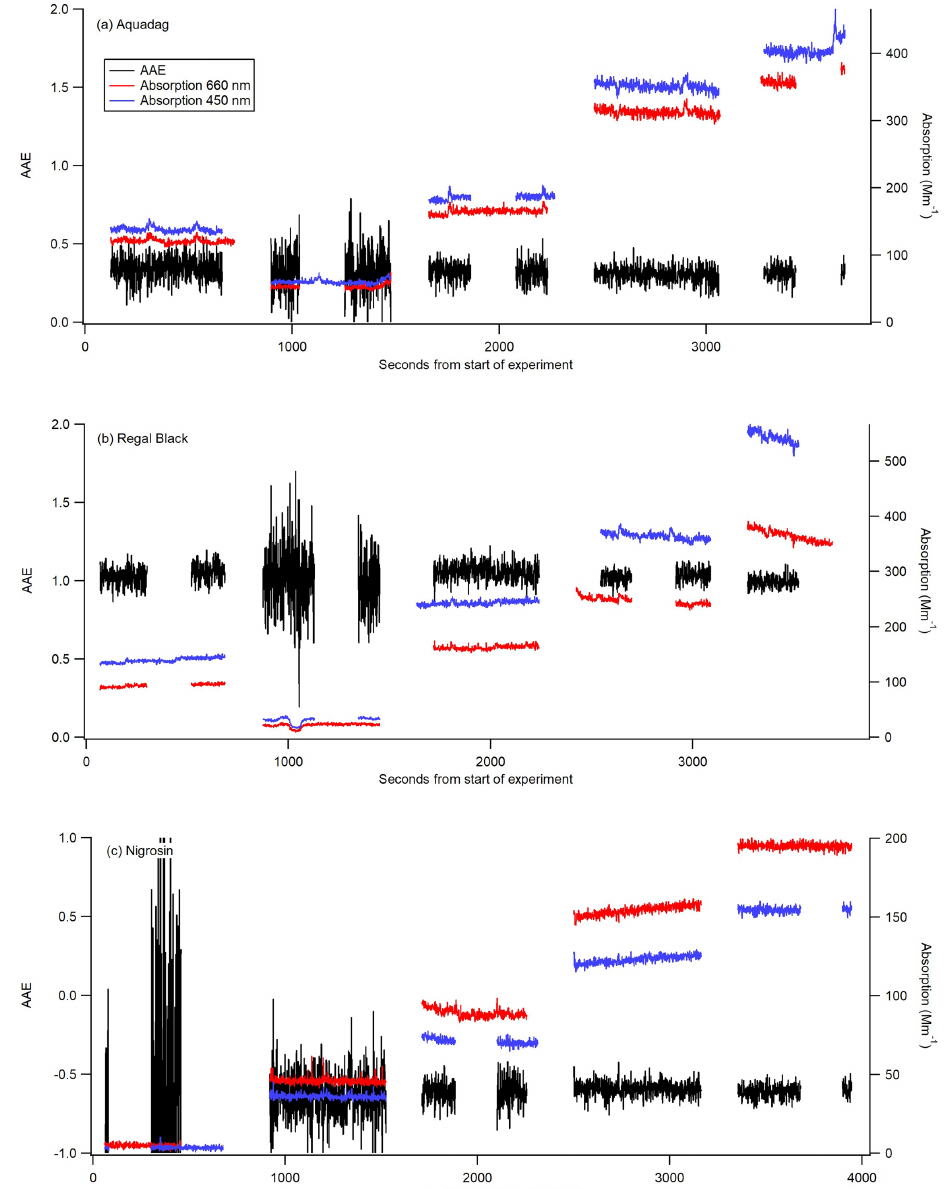
Figure 3. AAE (black) calculated from 1Hz data from the CAPS PM SSA data for three different substances: Aquadag (a) , Regal Black (b) , and Nigrosin (c) . The 450nm (blue) and 660nm absorption (red) coefficients are taken from the CAPS PM SSA instrument. The absorption coefficients are shown for context, as the AAE becomes significantly more noisy at low concentrations. Gaps in data occur when the CAPS is conducting a baseline period, and the instruments are switched to filter for several minutes between each